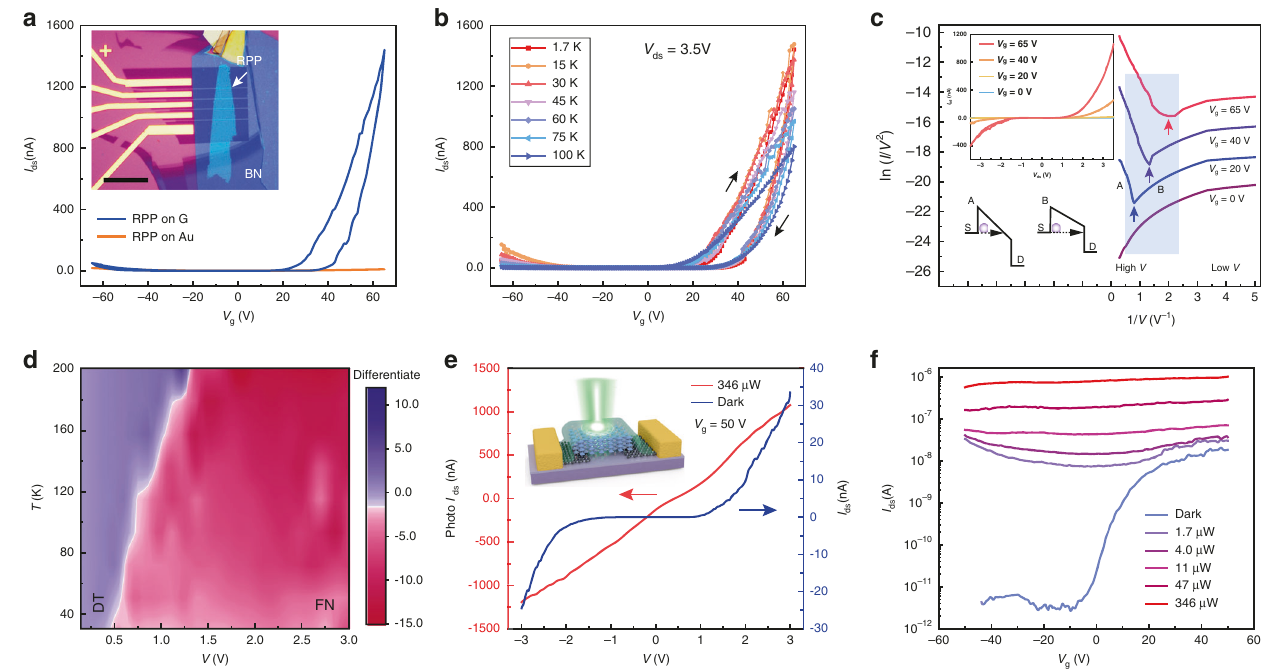
2D perovskite FET devices ( n = 4) and their photo-electrical characterizations, using G or Au as electrodes. Fig. 3 a Transfer characteristics of RPP/G and RPP/Au FET devices at 1.7 K. Inset, Optical image of a typical bilayer thick 2D RPP device using G as electrode. Source-drain channel length is 300 nm. Scale bar, 15 µ m. b Temperature-dependent transfer characteristics at 1.7 – 100 K for RPP/G FET. c Fowler-Nordheim (F-N) plots of 2D RPP/G, with each plot collected at a fi xed gate voltage. The minimum voltage highlighted by the arrow is the transition point from direct tunneling (DT) to F-N as voltage increases. Schematic diagrams corresponding to F-N tunneling (point A) and DT (point B). Inset, I ( V ) curves corresponding to the F-N plot. d Temperature- dependent color map of F-N plots. The white line indicates the transition boundary between DT and F-N tunneling. e Output characteristics in the dark and under laser illumination based on 2D RPP/G FET device at 77 K. f Transfer characteristics in the dark and under different illumination intensities for RPP/G device at 77 (blue)-to-linear I-V behavior (red) transition, as shown in Fig. 3e and Supplementary Fig. 13a. Photo-irradiation creates photo-